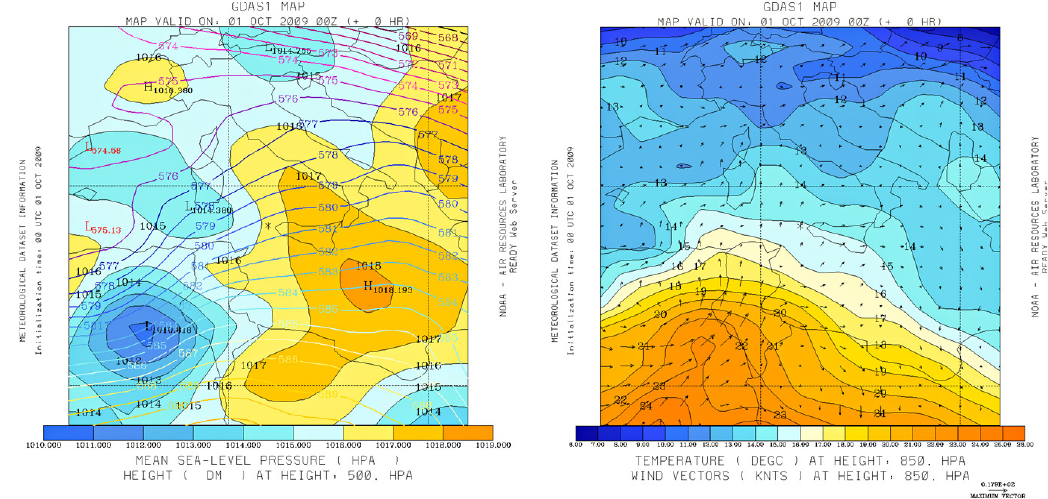
Fig. 5. National Centres for Environmental Prediction (NCEP) Global Data Assimilation System (GDAS) model output on 00:00UTC of 1 October 2009 – Left panel) Mean sea level pressure and 500mbar level geopotential – Right panel) Winds and thermal field at 850mbar